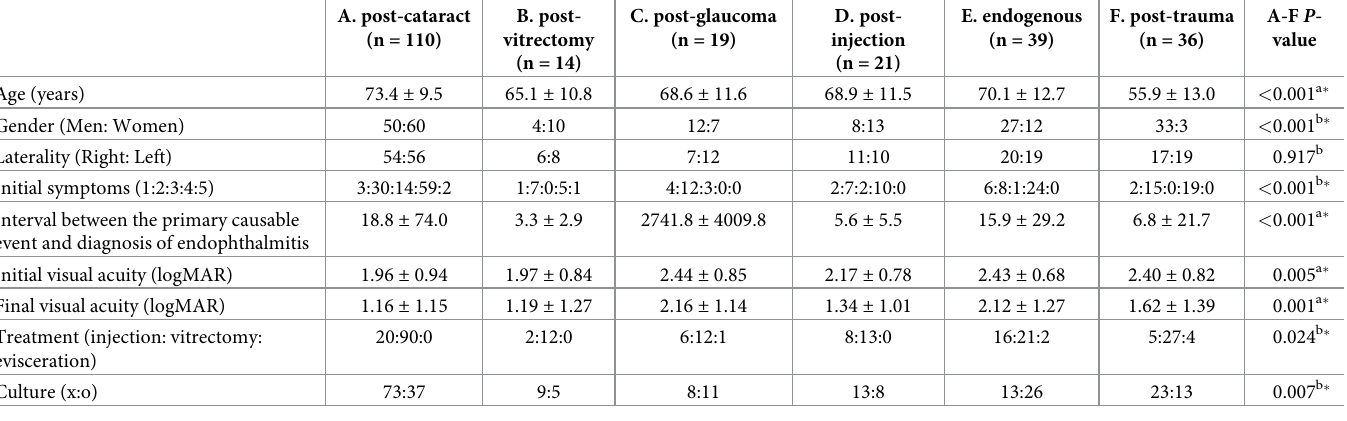
Table 4. Comparative analysis of endophthalmitis according to its causes or